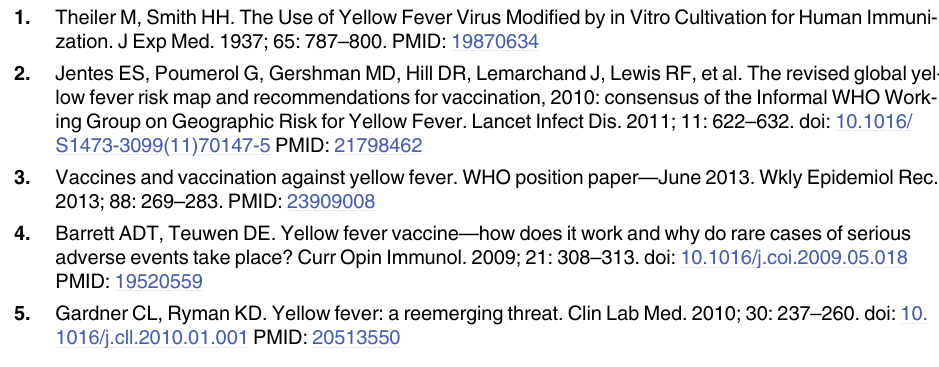
S1 Fig. Serum cytokine levels in vaccinated and non-vaccinated mice infected with wtYFV. (TIF) S2 Fig. Representitive magnetic enrichment profile of lymphocytes/splenocytes from 17D- 204 or mock vaccinated mice. Flow cytometry histogram plots of pre-sort or magnet enrich- ment fractions are displayed. Each fraction was stained for CD19, CD8 and CD4. The percent- age displayed represents the total cells in that fraction that are positive for the specific stain as indicated by the placement of the gate. T cells. S3 Fig. Expression of CD44 and CD62L on CD11a hi S4 Fig. Analysis of human type I interferon gene expression following 17D vaccination. GEO2 data [8] analysis of type I interferon gene expression in humans following 17D infection (GSE13486-GPL7567) were obtained by the getGEO package in R. A day 0 (D0) group was paired with individual groups for time points; D1, D3, D7 or D21. Each set was combined into a single data frame. The Uniprot.ws package was then used to annotate the gene data specific for interferon alpha and interferon beta genes. Plots are displayed as fold change from day 0 by a 2^logFC transformation. Statistical relevance was determined using the adjusted P value